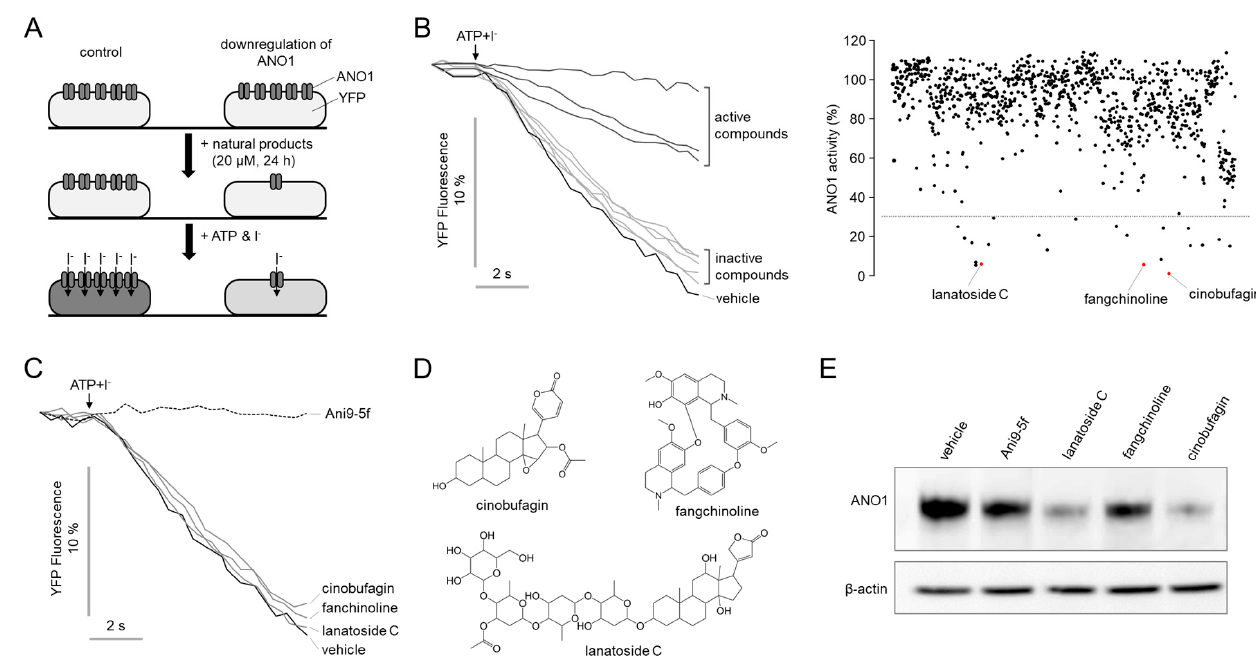
Figure 1. Identification of novel compounds that downregulate ANO in CAL-27 cells. ( A ) Principle of high-throughput screening assay. ( B ) Representative YFP fluorescence traces. YFP fluorescence monitored in CAL-27 cells treated with 20 μ M test compounds for 24 h. (right) Dot plot of primary screening results for 730 natural products. ( C ) Representative YFP fluorescence traces showing the effect of short-term (10 min) exposure of 20 μ M cinobufagin, fangchinoline and lanatoside C on ANO1 channel activity in CAL-27 cells. ( D ) Chemical structures of cinobufagin, fangchinoline and lanatoside C. ( E ) Effects of Ani9-5f, cinobufagin, fangchinoline and lanatoside C on ANO1 protein expression levels were assessed by Western blot analysis. CAL-27 cells were treated with 10 μ M of the test compounds for 24 h.